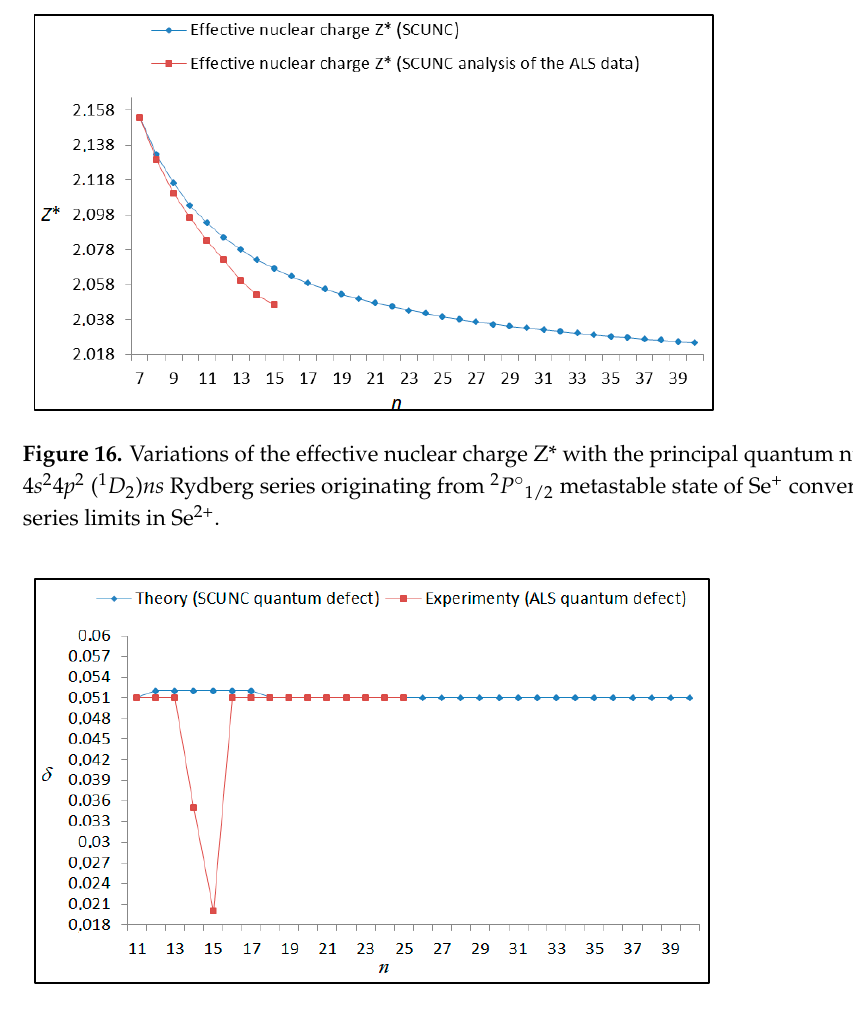
Figure 17. Variations of the quantum defect ( δ ) with the principal quantum number n for the 4 s 2 4 p 2 ( 1 D 2 ) ns Rydberg series originating from the 2 D ° 3/2 metastable state of Se + converging to the 3 P 2 series limits in Se 2+ .